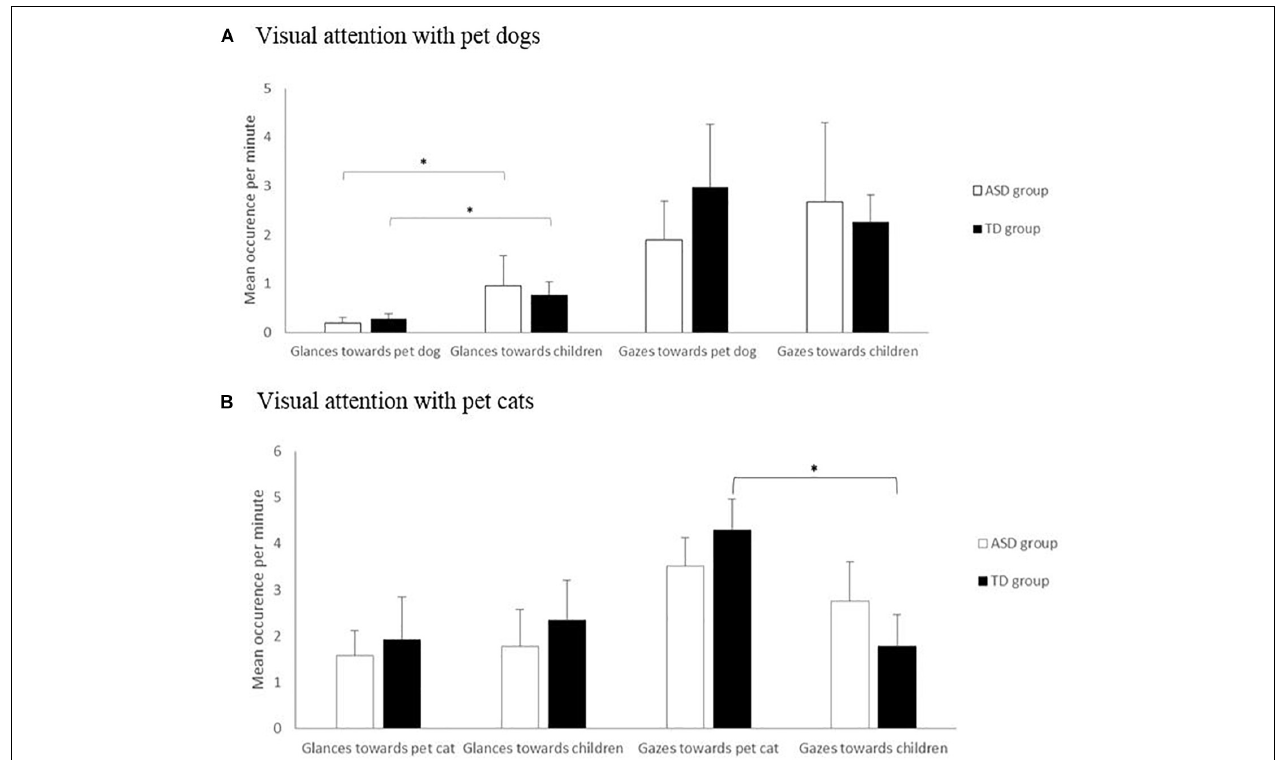
FIGURE 1 | Visual attention in the autism spectrum disorders (ASD) and typically developing (TD) groups in occurrence per minute (glances and gazes) in pet dog–child (A) and pet cat–child (B) dyads. Mann–Whitney and Wilcoxon tests. ∗ p <